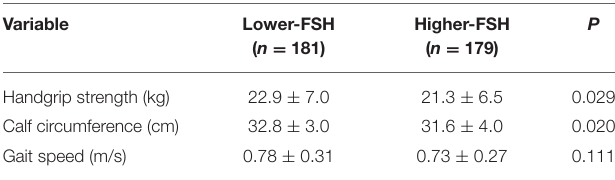
TABLE 2 | Sarcopenia associated components in older males stratified by the follicle-stimulating hormone (FSH) median